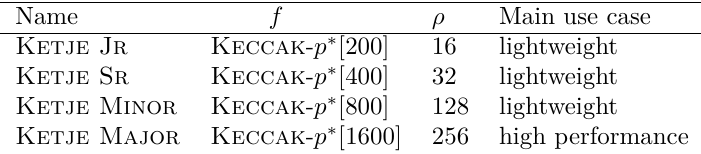
Table 2: Four Instances in Ketje